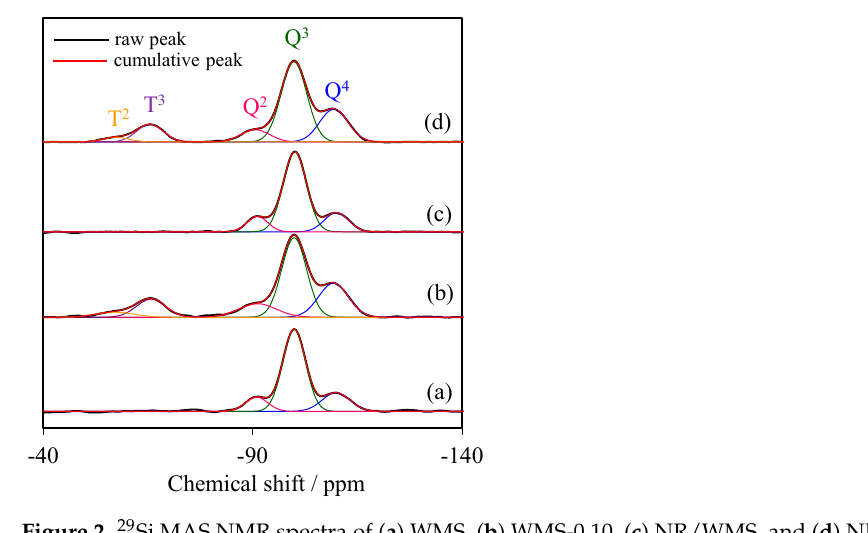
Figure 2. 29 Si MAS NMR spectra of ( a ) WMS, ( b ) WMS-0.10, ( c ) NR/WMS, and ( d ) NR/WMS-0.05. Table 1. Relative intensities of the T m and Q n species obtained from the deconvolution of 29 Si CP/MAS NMR spectra.